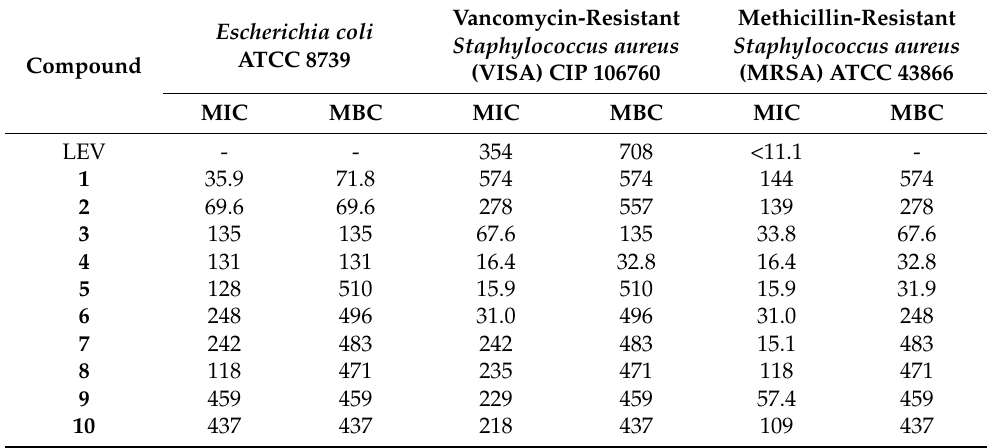
Table 3. Antimicrobial activity expressed as MIC and MBC values ( µ M) for selected Gram-negative ( E. coli ) and Gram-positive ( Staphylococcus aureus ) bacterial strains.